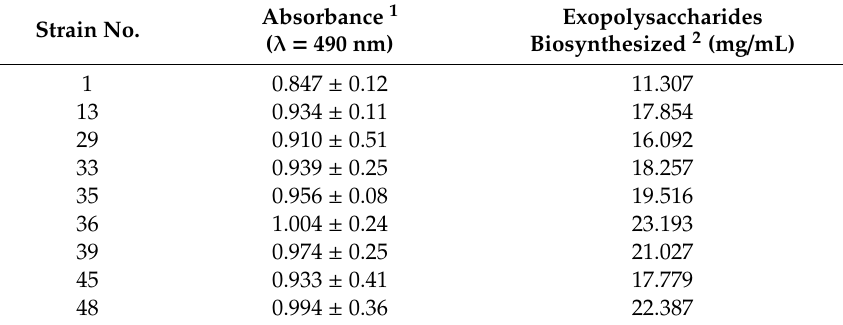
Table 2. Production of exopolysaccharides by presumptive LAB strains. Strain No.